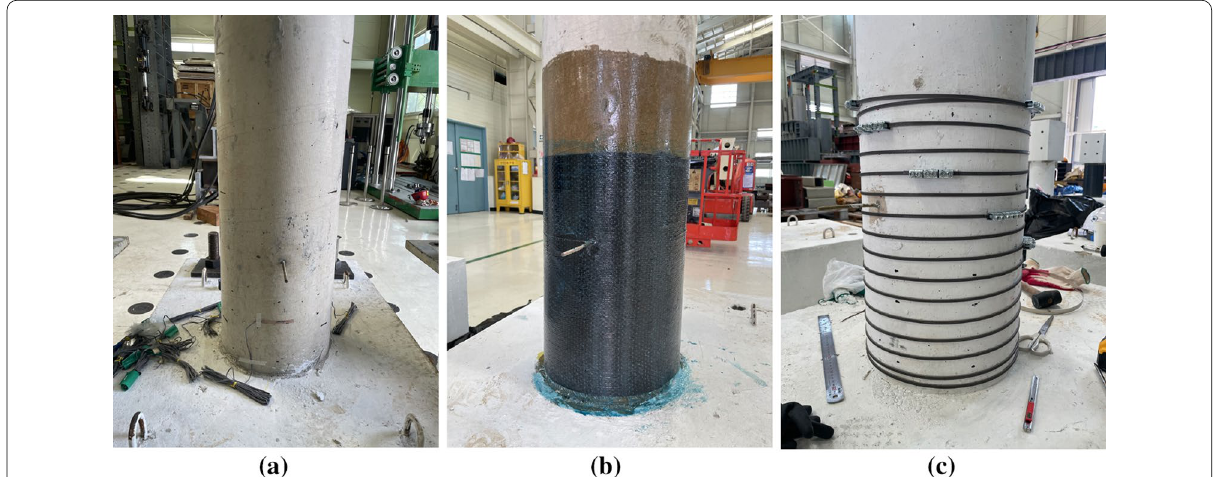
Fig. 6 Photos of column specimens after seismic retrofitting. a Control; b CFRP; c